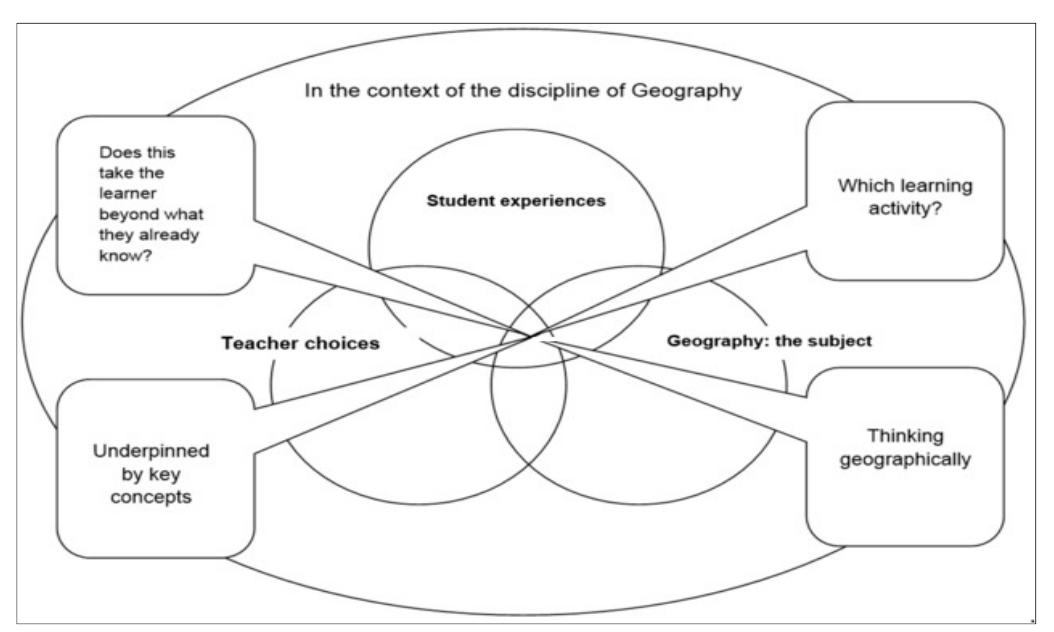
Figure 4. The curriculum making model.